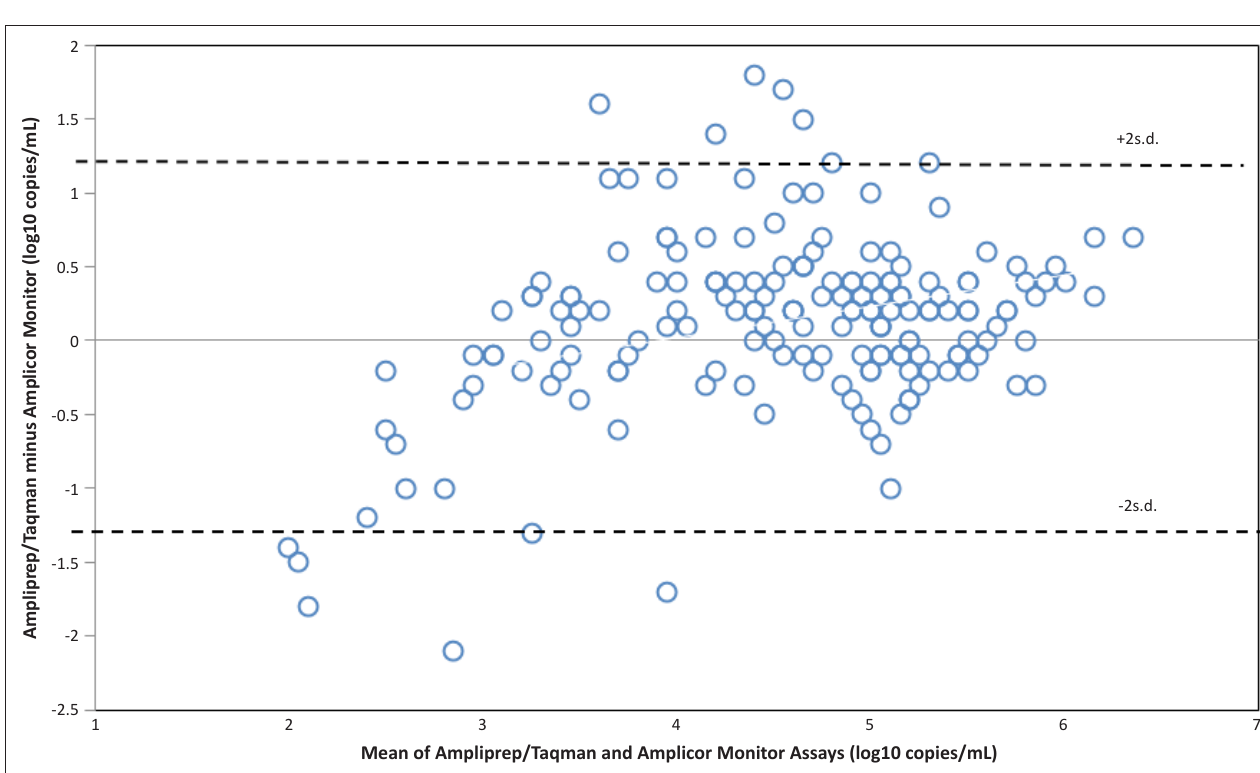
FIGURE 1: The correlation coefficient between the COBAS Ampliprep/Taqman HIV-1 assay and the COBAS Amplicor assay.